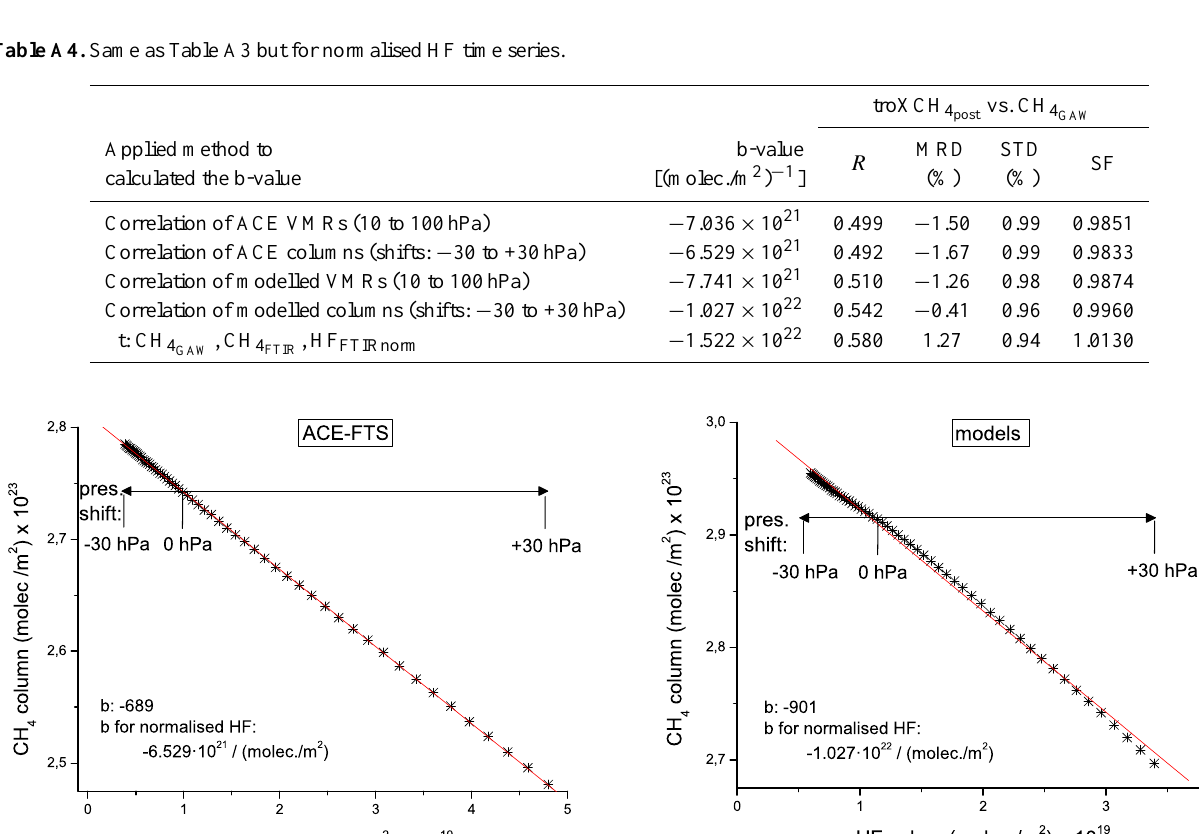
Table A3. Same as Table A1 but for CH 4